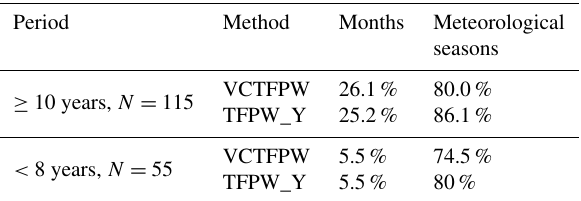
Table 4. Percentage of yearly trends with homogeneous temporal segments as a function of the type of segment (month or season), of the prewhitening method and of the length of the periods based on all seven time series considered in this